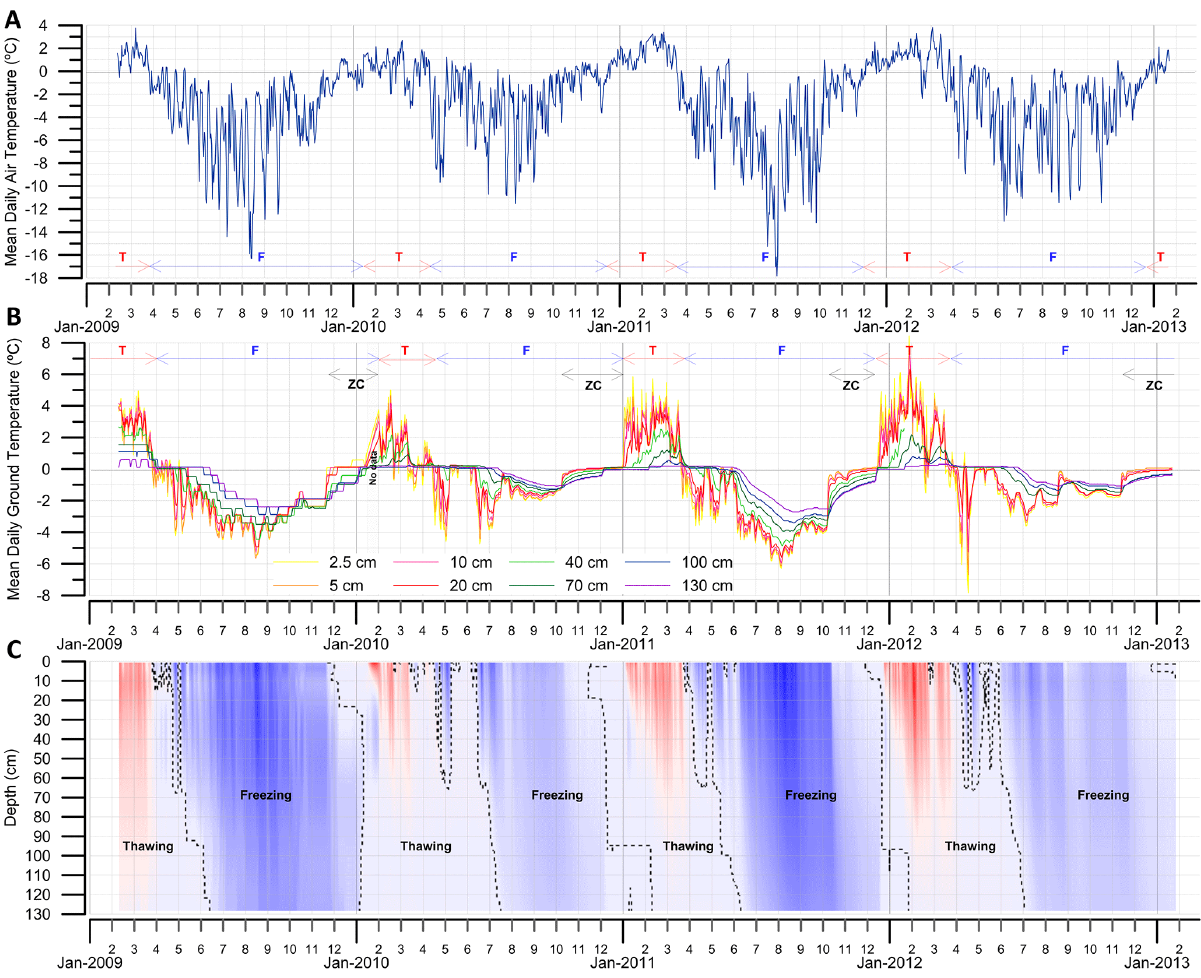
Figure 3. Mean daily temperature data of the air (A) and the ground at different depths in the 130cm depth borehole (B) of the Limnopolar Lake CALM site, showing the freezing (F), thawing (T) and zero curtain periods (ZC), and (C) the resulting thermogram for the monitoring